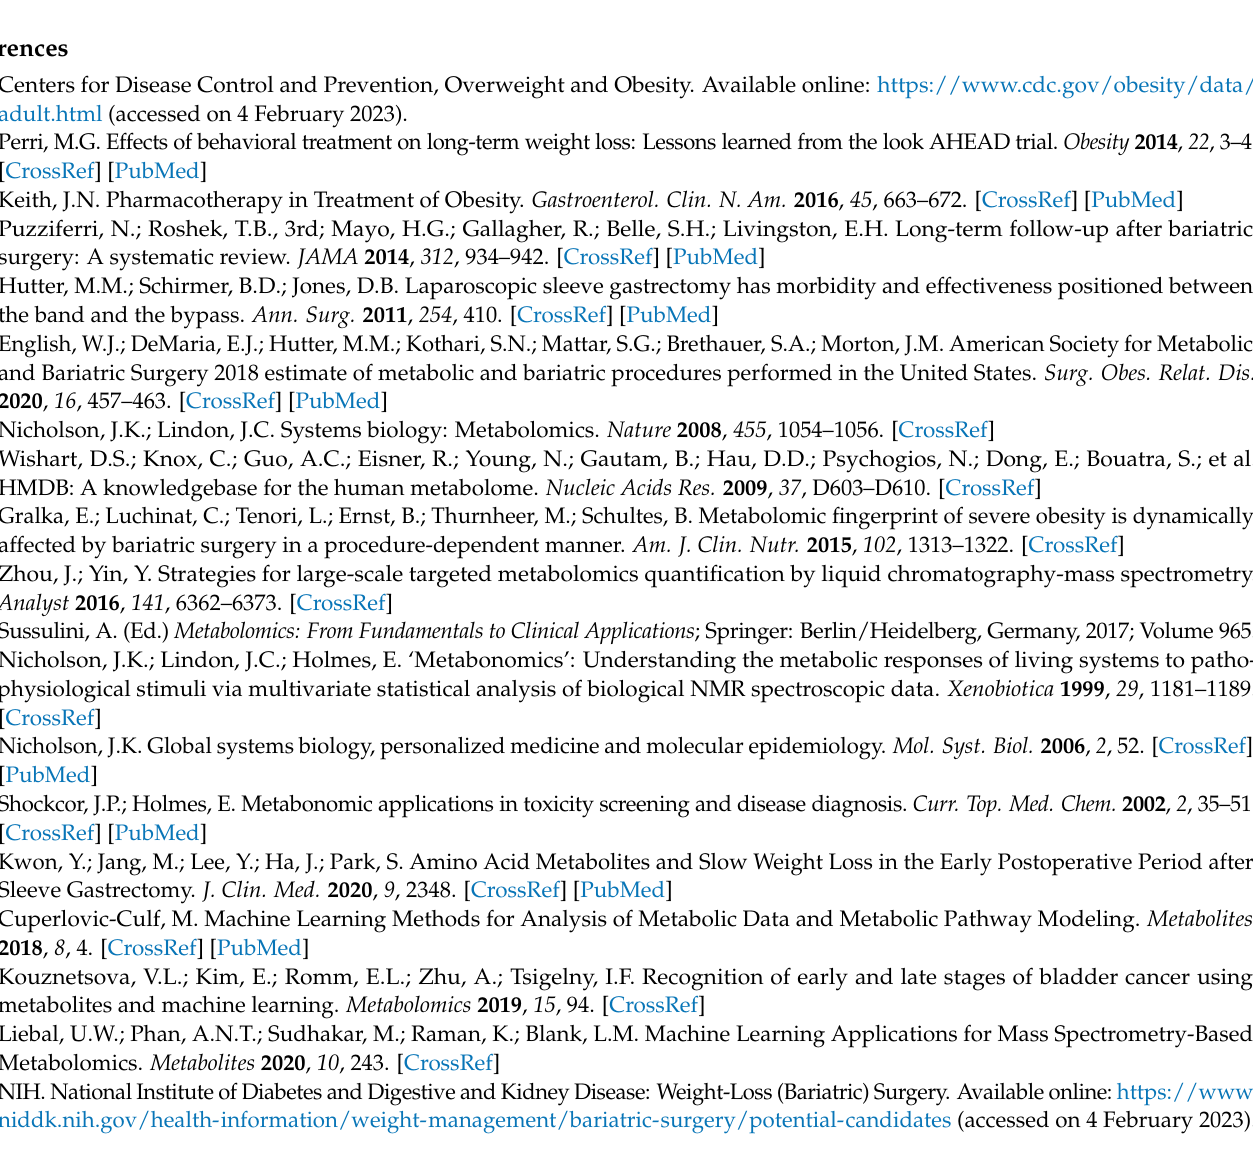
patients at baseline; Table S9: Univariate analysis results of only females for each variable/metabolite of tertile 3 at three months post-sleeve gastrectomy compared with only female patients at